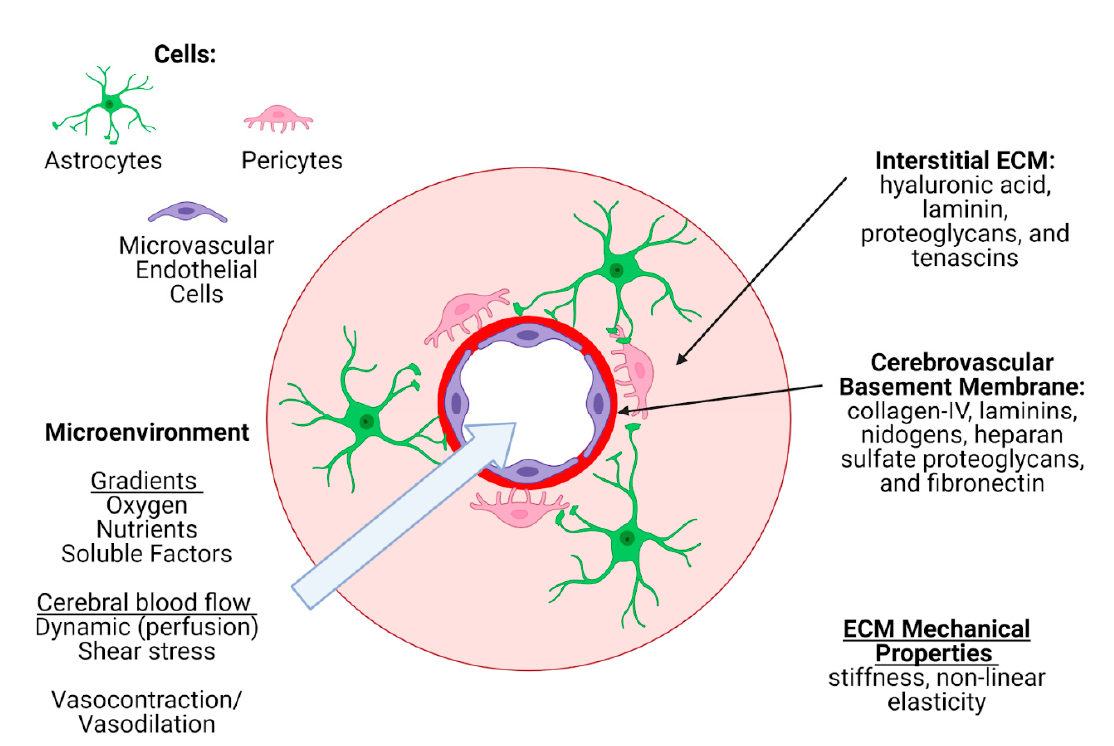
Figure 6. Components included in an MVM of the BBB.